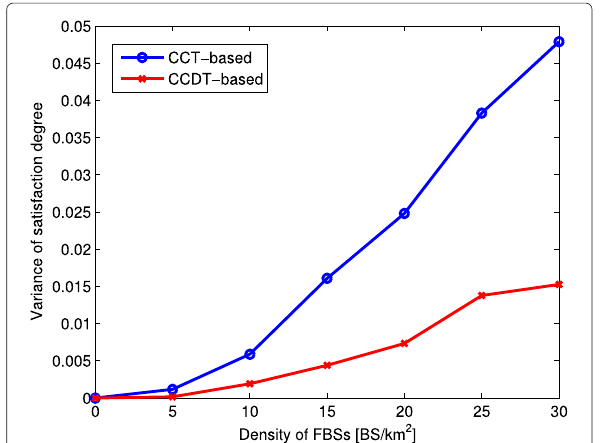
Fig. 3 Variance of satisfation degree for different density of